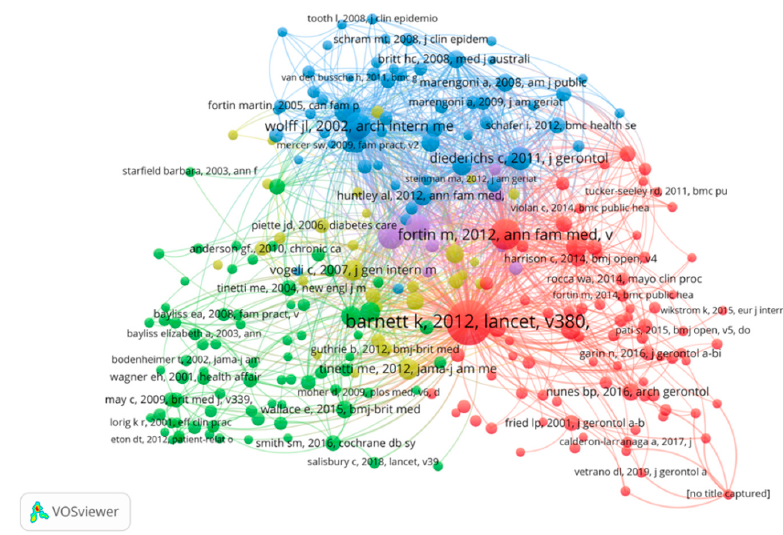
Figure 11. Co-cited analysis of global publications. Table 7. TOP 10 highly cited papers in English.